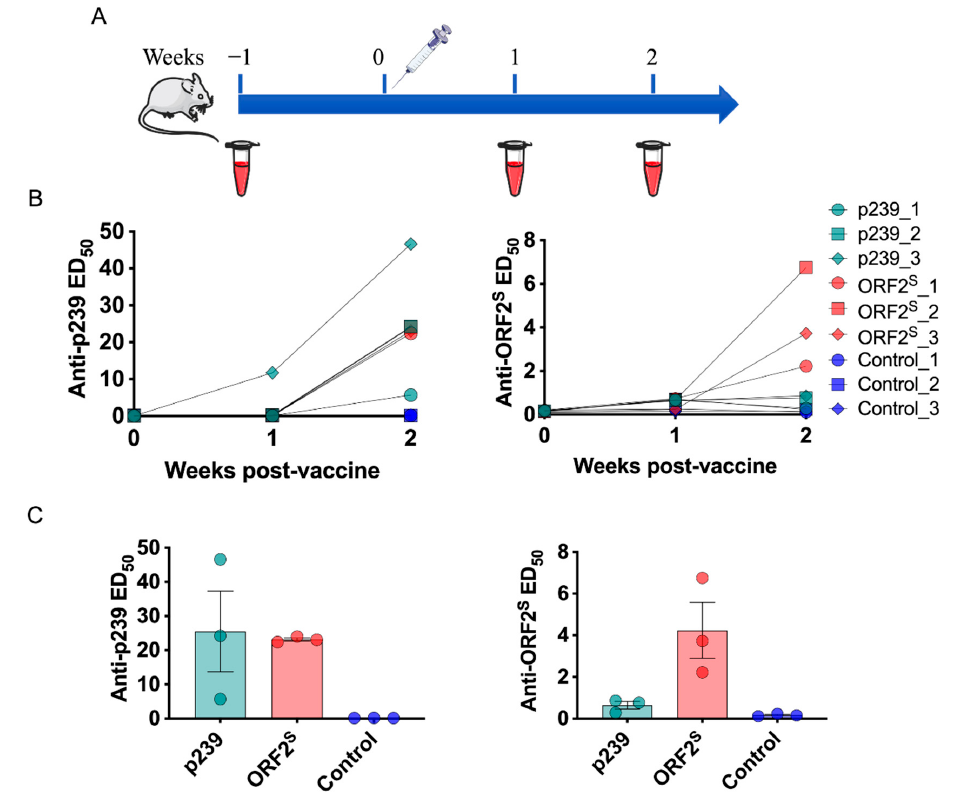
Figure 3. ORF2 S as an immunogen for assessing immunogenicity. ( A ) Immunization schemes of the animal experiments. BALB/c mice were administered one dose of 20 μ g ORF2 S (tPA), p239, or PBS, and serum samples were collected weekly. ( B ) Serum anti-HEV IgG titers over time. The ORF2 S (tPA) and p239 proteins of HEV gt4 were tested separately. The data are shown as the median effective dose (ED 50 ). ( C ) Comparison of anti-HEV IgG serum titers in mice at the second week. Black bars indicate the standard error of the mean (SEM). The column data show the mean with SEM.